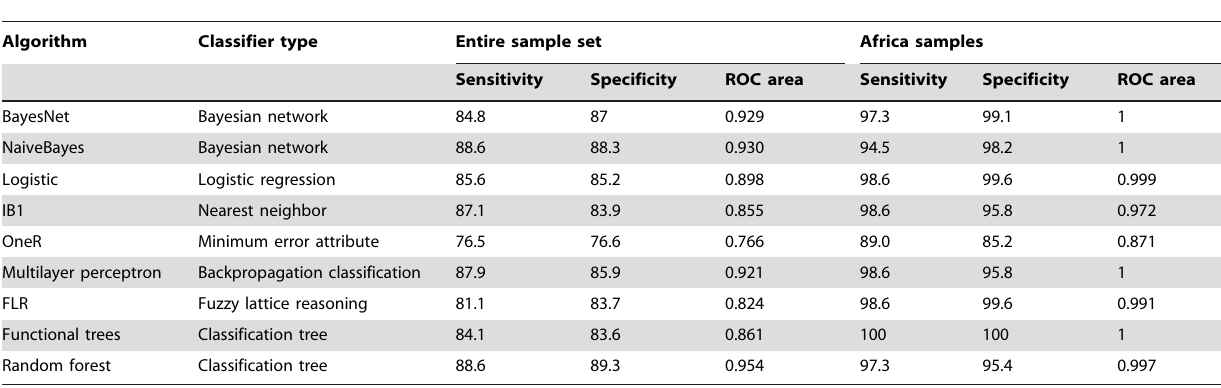
Table 3. Summary of the diagnostic accuracy of the machine learning algorithm analysis.